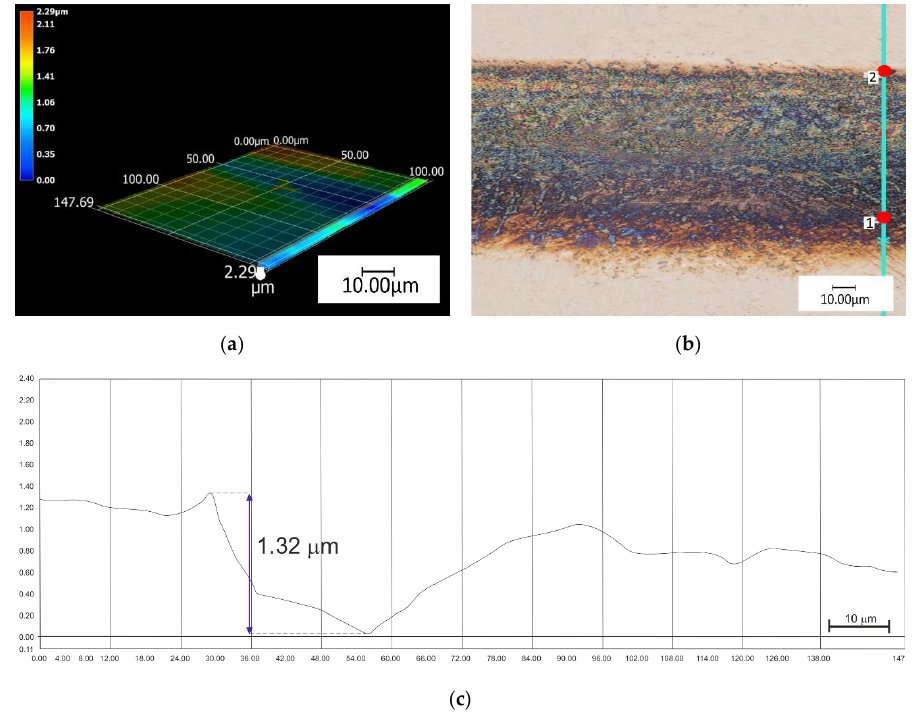
Figure 5. The results of digital microscopy observation for the 4th sample group M4: ( a ) 3D visualization